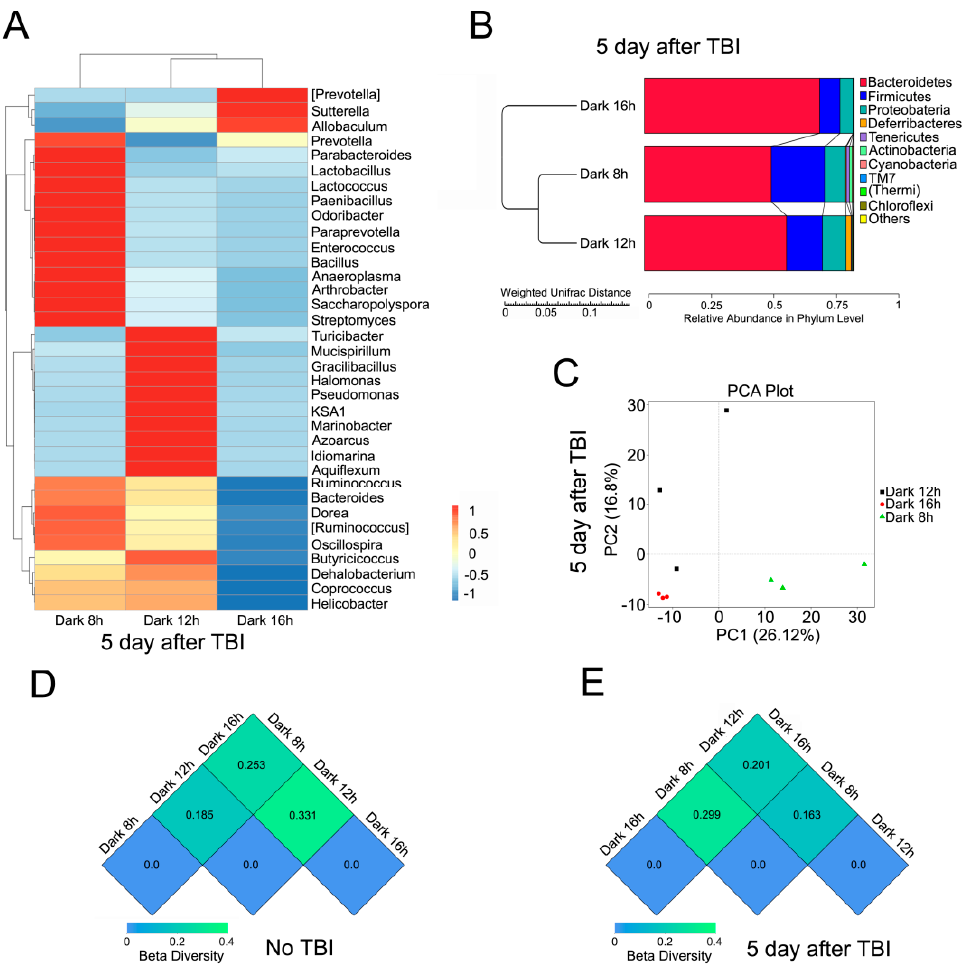
Figure 3. Circadian rhythm affects the structure of gut bacterial composition after irradiation. ( A ) The differences in intestinal bacterial structure at the genus level among irradiated mice from the three cohorts was validated using 16S high throughput sequencing, n = 3 per group. The color bar denotes the z-scores; ( B ) The relative abundance of bacteria at the phylum level was examined among irradiated mice from the three groups using 16S high throughput sequencing, n = 3 per group; ( C ) Principal component analysis was performed on irradiated mice from the three groups using 16S high throughput sequencing; ( D , E ) The β diversity among mice, without ( D ) or with ( E ) irradiation, was analyzed using 16S high throughput sequencing, n = 3 per group.